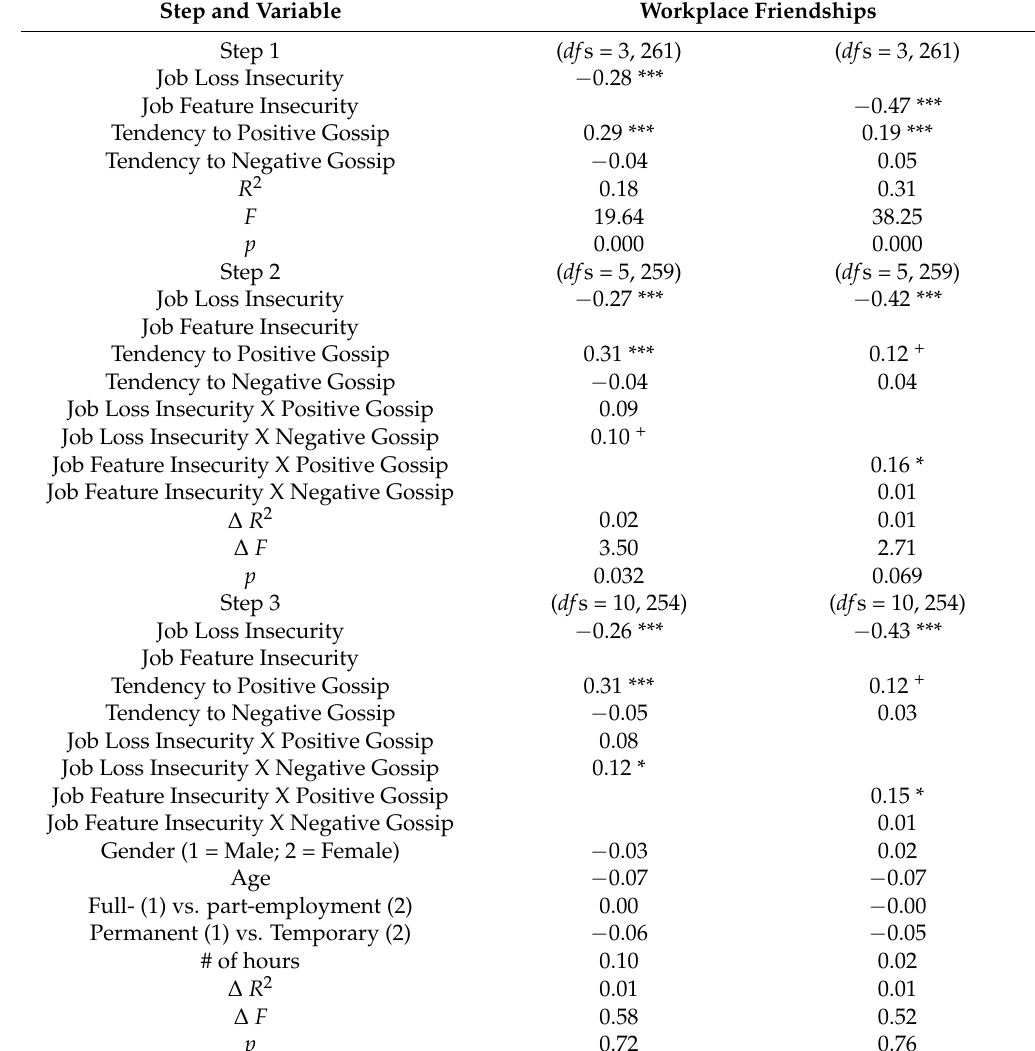
Table 2. Regression analysis